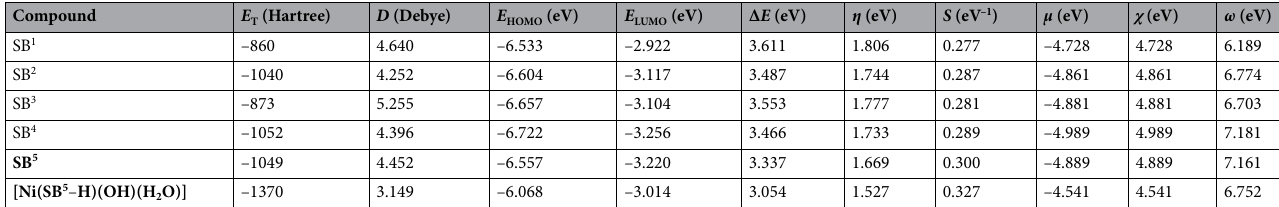
Table 3. The molecular parameters of Schiff bases and the Ni(II)–SB 5 complex calculated by DFT-B3LYP/ Lanl2dz method.